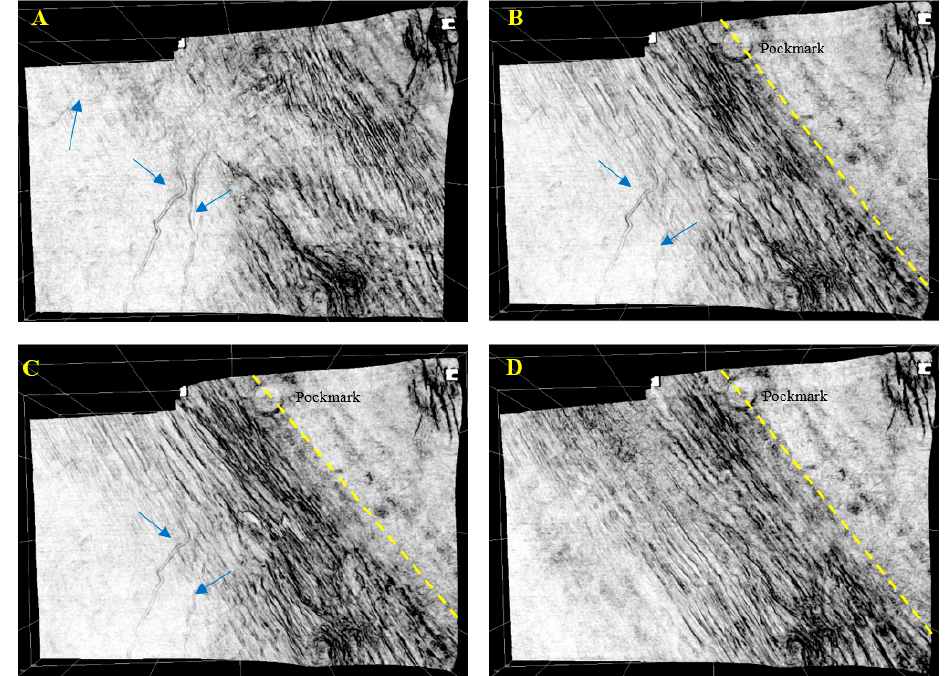
Figure 10. The minimum similarity attributes for each surface. ( A ) Maximum flooding surfaces 1 (MFS1); ( B ) basal surface force regression 1 (BSFR1); ( C ) correlative conformity and sub-aerial conformity 1 (CC/SU1); and ( D ) maximum regressive surface 1 (MRS1). The yellow dashed line indicates the paleo-coastline position. The existence of a deep meandering channel is denoted by the blue arrows.